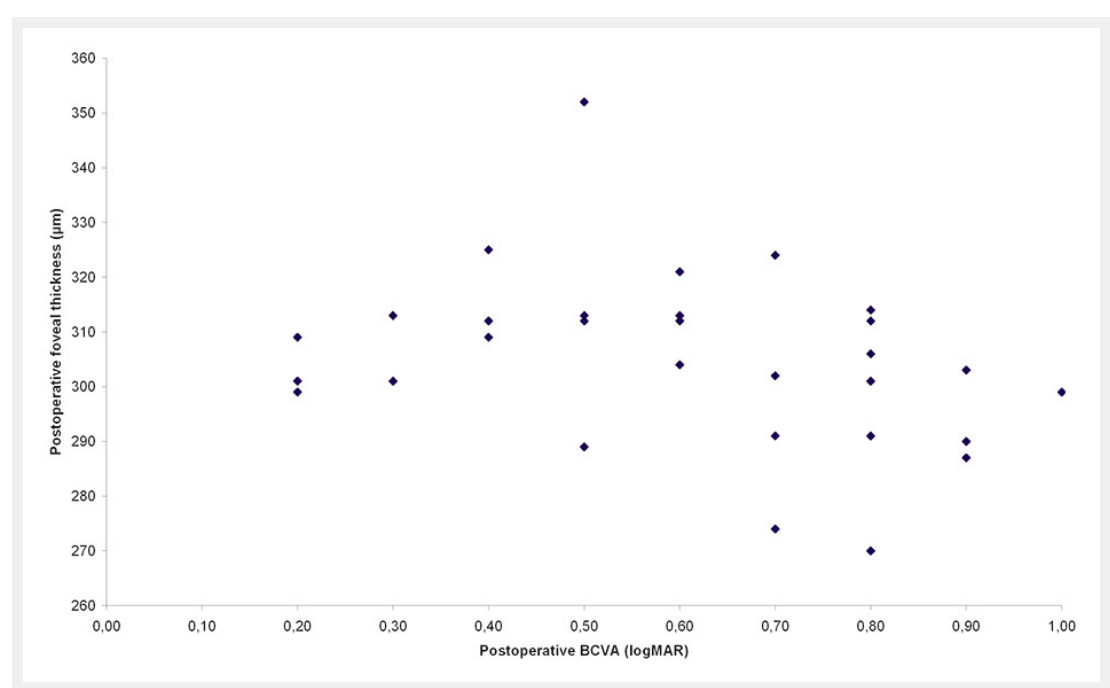
Figure 1 Linear regression analysis of the relationship between postoperative best-corrected visual acuity (BCVA) and postoperative foveal thickness assessed with optical coherence tomography (OCT). No correlation was observed between these two variables (Pearson’s correlation coefficient, r = 0.228; p =